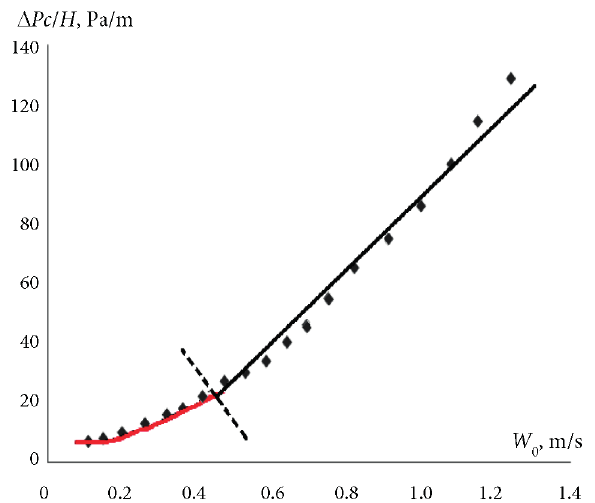
Fig. 7. Dependence of the pressure drop Δ P velocity W for the dry packing under test (pine 0